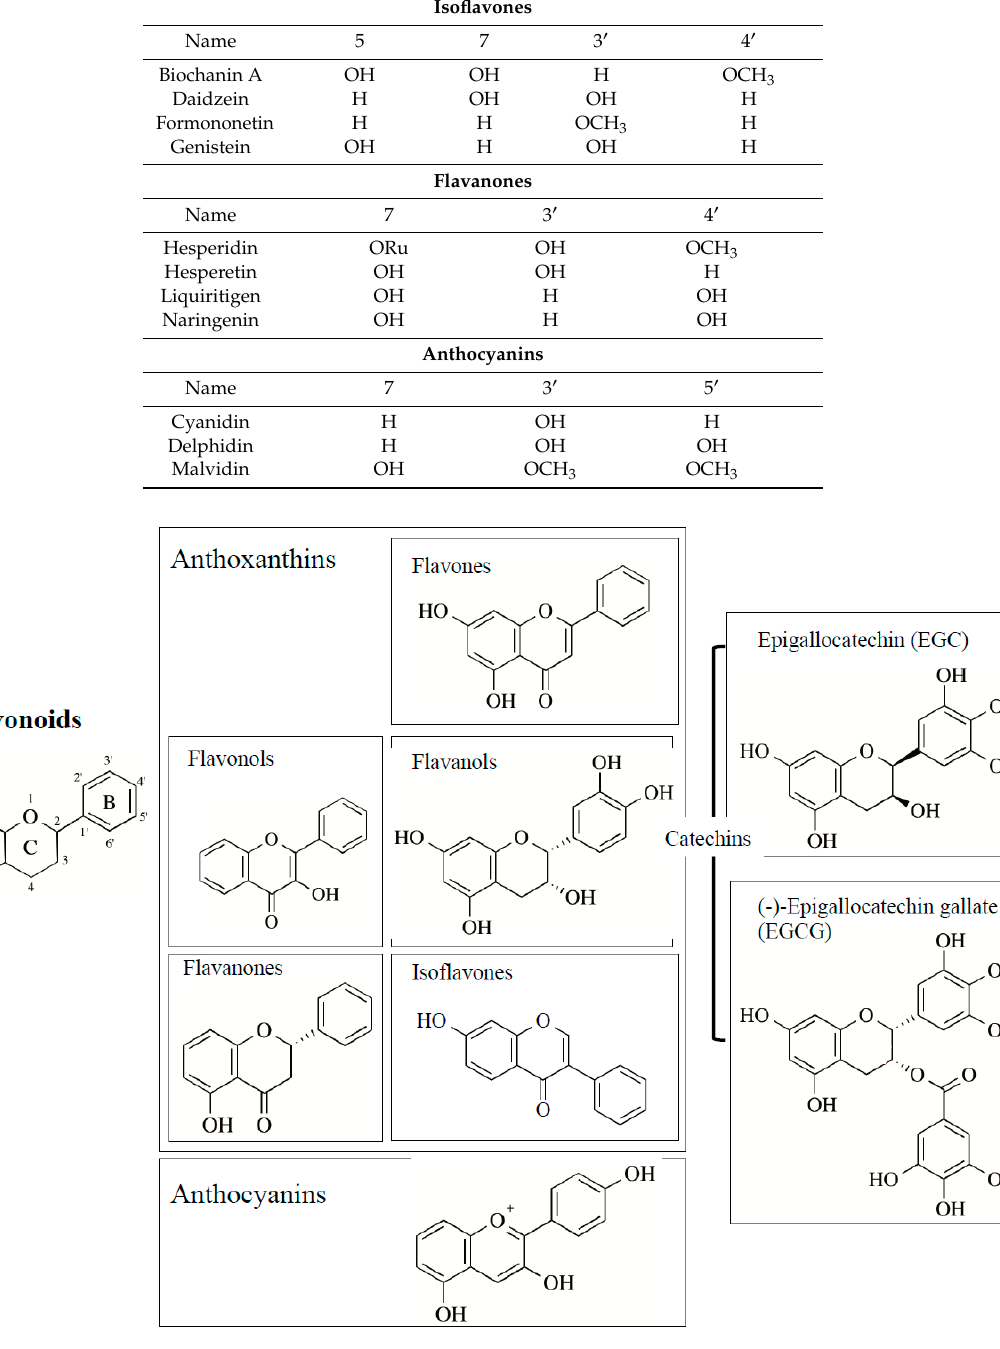
Figure 3. Classification and structures of major flavonoi s. Flavonoids are classified into anthoxanthins (flavonols, flavanones, flavones, flavanols and isoflavones) and anthocyanins, depending on the number and position of hydroxyl groups. Chemical structures of epicatechin-3-gallate (EGC) and epigallocatechin-3-gallate (EGCG) are also shown. The chemical structures of individual flavonoids are shown in Table